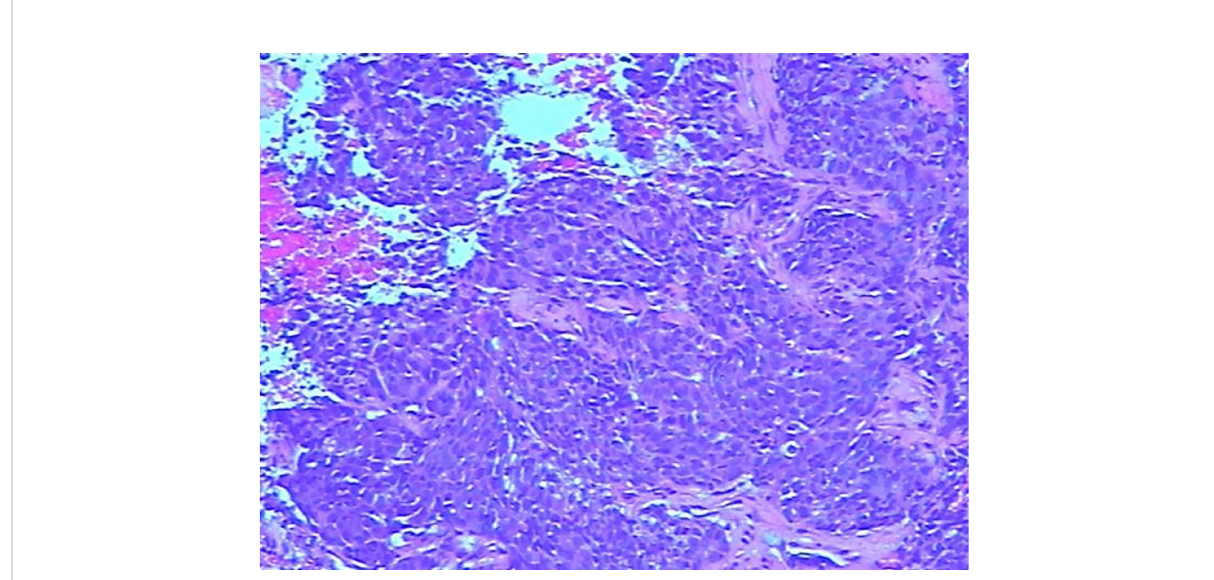
FIGURE 2 Puncture pathology of left breast